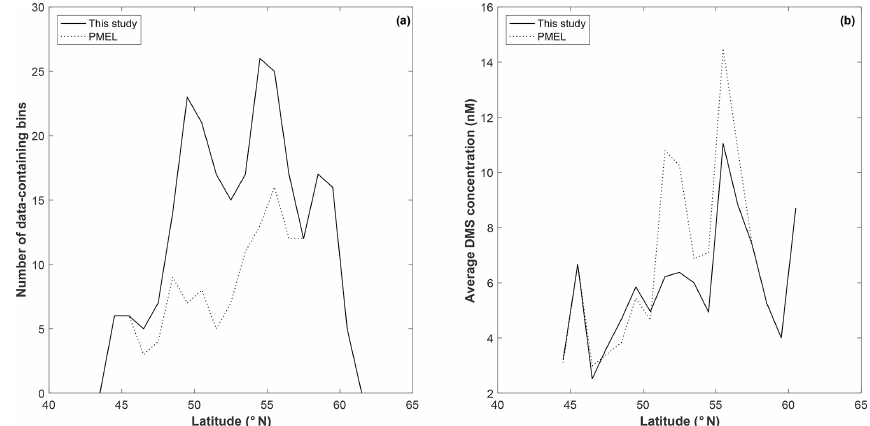
Figure 9. Latitudinal distribution of data-containing bins (a) and average DMS concentration (b) for PMEL (dotted line) and combined (PMEL and MIMS) data sets. Table 3. Mean DMS concentrations, sea–air fluxes and total summertime DMS flux for the PMEL data set utilized by L11 and the updated databases used in this study. PMEL This study Province DMS DMS flux Total summer